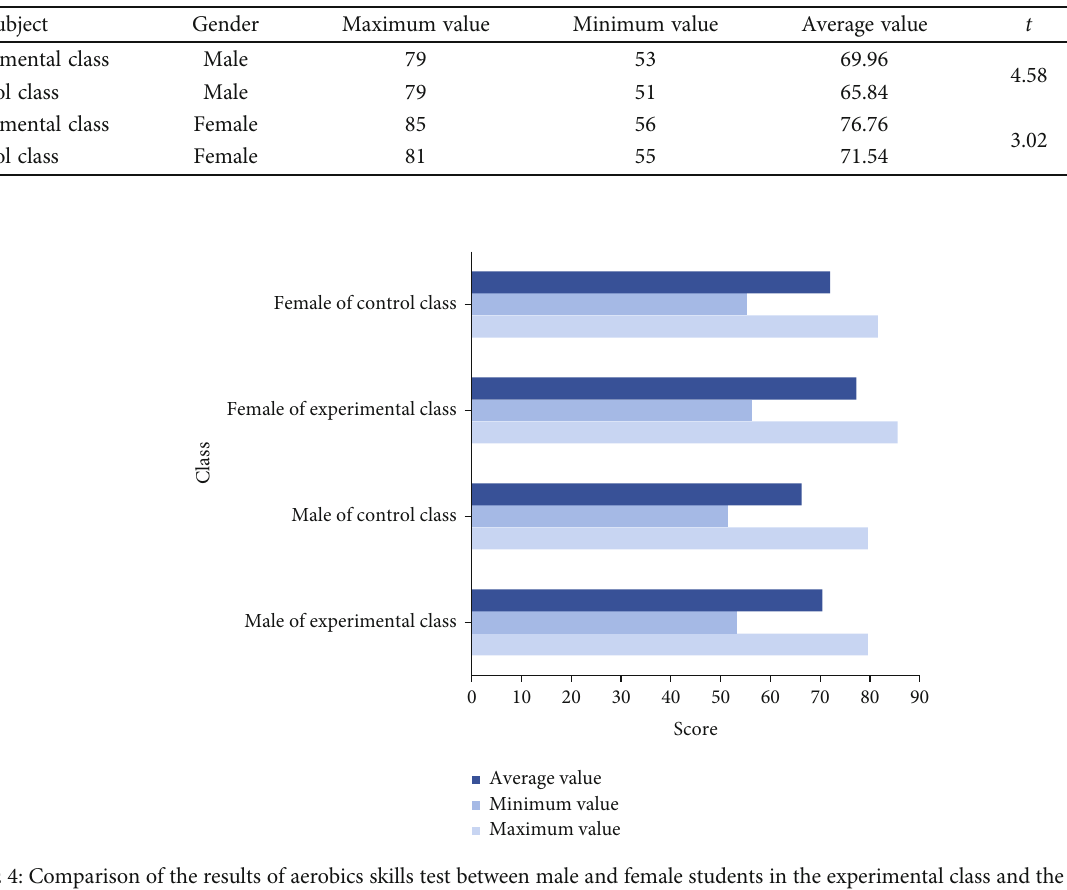
Table 4: Comparison of the results of aerobics skills test between male and female students in the experimental class and the control class.